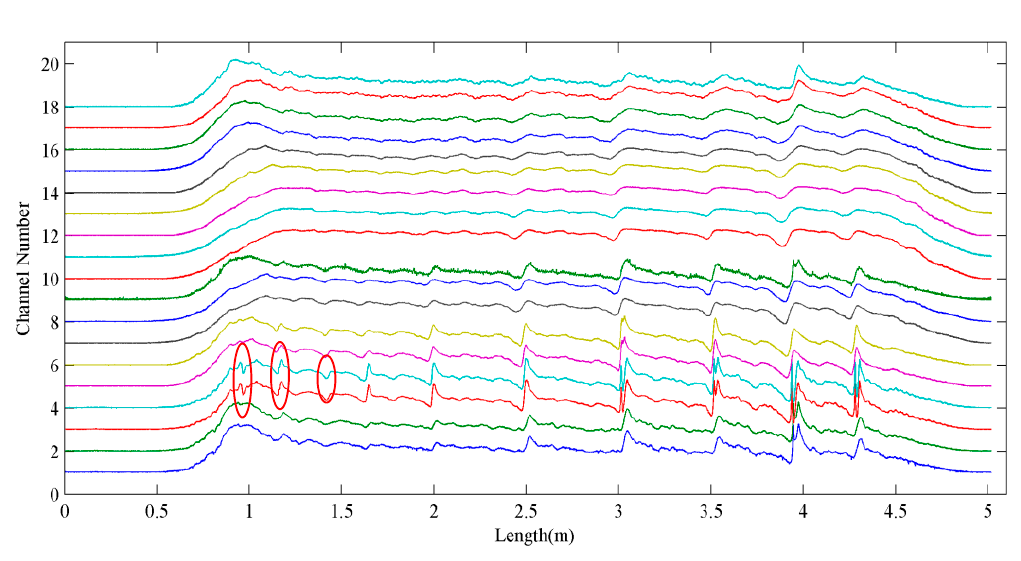
Figure 6. UME raw testing of magnetic flux leakage (MFL) signals of 18 channels.